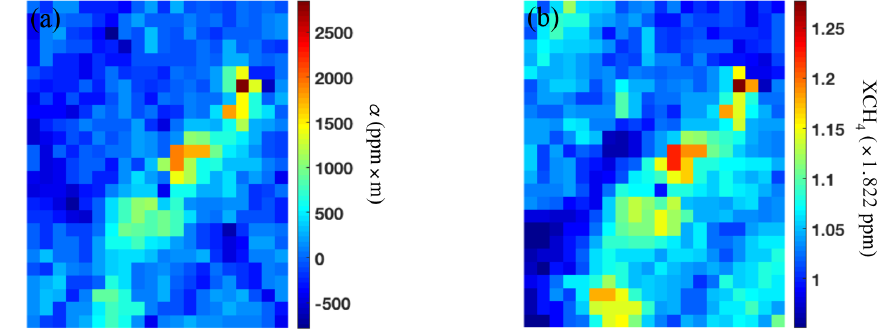
Figure 4. Retrieval image for the plume center (500 elements) based on the (a) MF method and (b) OE method.